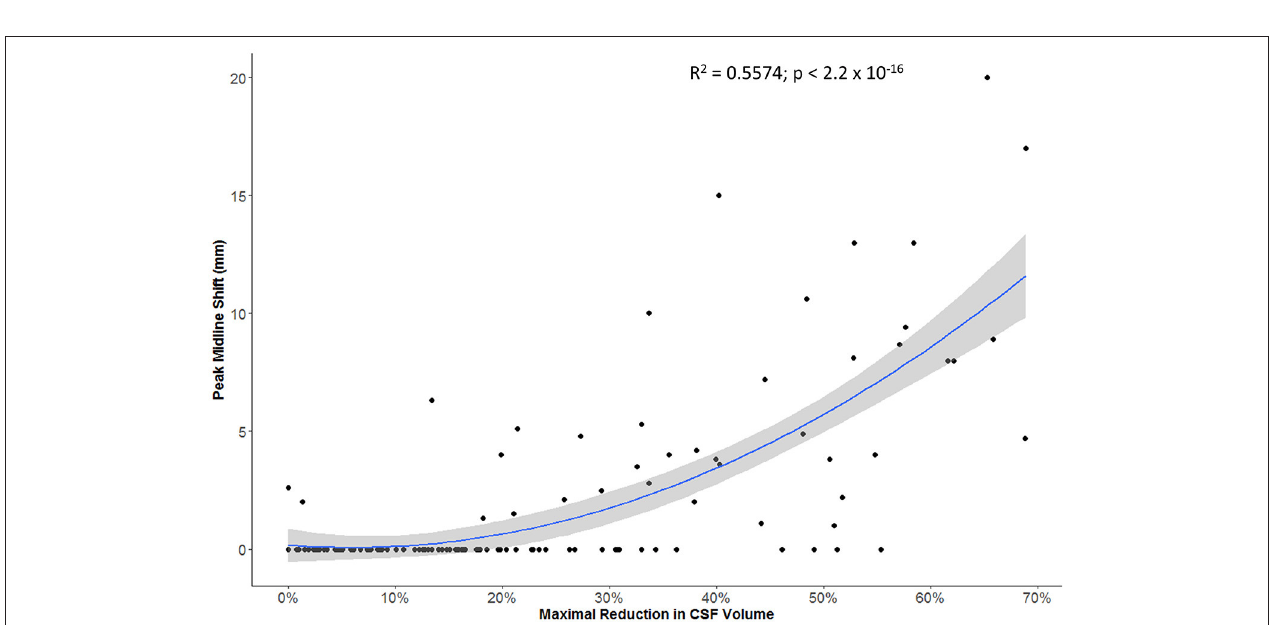
FIGURE 5 | Relationship between maximal reduction in CSF volume (relative to baseline) and peak degree of midline shift (gray zone represents 95% confidence interval for predictions from the quadratic regression